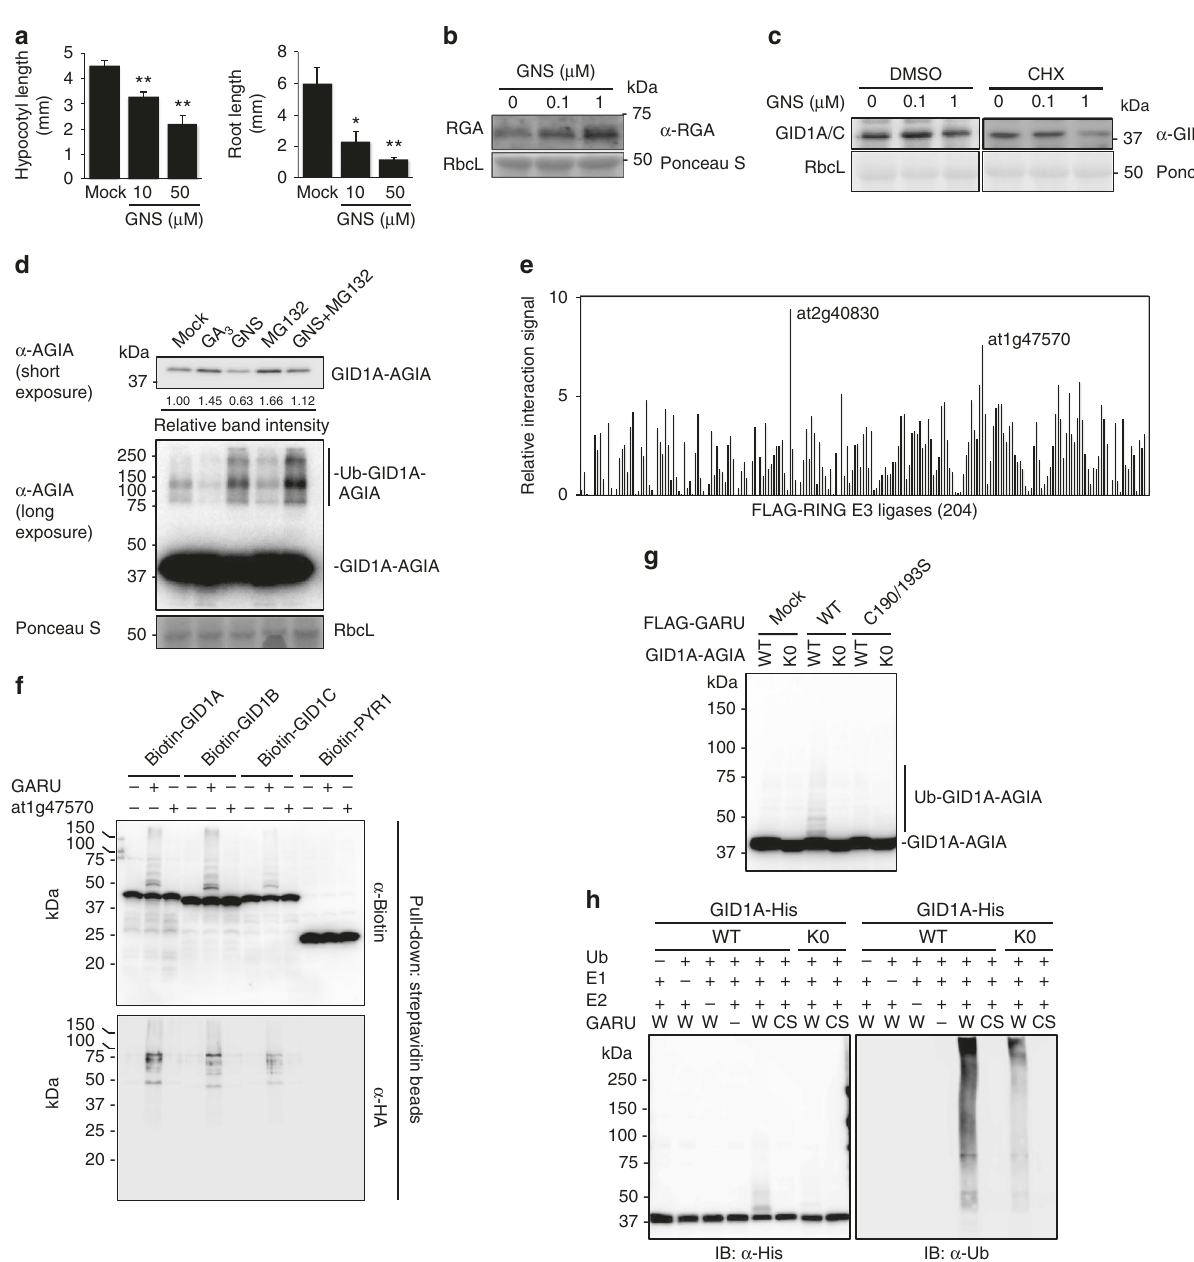
Fig. 1 Identi fi cation of GID1-interacting RING-type E3 ubiquitin ligase GARU. a Hypocotyl elongation assay of etiolated seedlings (left) and primary root elongation assay (right) in response to GNS. Error bars indicate ± s.d. of three replicates, n = 24 (hypocotyl), and n = 20 (root). Statistically signi fi cant changes compared with Mock are indicated ( *P < 0.05, **P < 0.01, as determined using two-tailed Student ’ s t -test). b Immunoblot analysis of RGA protein in Col-0 seedlings that were treated with GNS for 6 h. c Immunoblot analysis of endogenous GID1A/C proteins in Col-0 seedlings that were treated with GNS and 300 μ M CHX for 6 h. d Immunoblot analysis of GID1A-AGIA in protoplasts that were treated with 10 µ M GA 3 , 5 µ M GNS, or 20 µ M MG132 for 6 h. Relative protein level was calculated as the signal intensity ratio of the Mock. e PPI analysis of biotin-GID1A and 204 FLAG-E3s. f In vitro ubiquitination assay using the top two interacting clones. Biotin-GID1A, GID1B, and GID1C were incubated with recombinant HA-tagged ubiquitin and E2 in the presence (+) or absence ( − ) of FLAG-tagged GARU or at1g47579 protein. After incubation, reaction mixture was boiled in 2% SDS, and biotin-GID1 proteins were collected by af fi nity puri fi cation using streptavidin magnetic beads. Biotin-GID1 proteins and HA-ubiquitin were detected by immunoblot analysis using anti-biotin antibody or anti-HA antibody. PYL1 was negative control. g In vitro ubiquitination assay using GID1A K0 mutant. C-terminal AGIA-tagged GID1A (WT) or GID1A K0 mutant (K0) was incubated with FLAG-GARU (WT) or FLAG-GARU C190/193S mutant (C190/193S). Ubiquitinated GID1A (Ub-GID1A- AGIA) proteins were detected by immunoblot analysis using anti-AGIA antibody. h In vitro ubiquitination assay using puri fi ed GID1A and GARU. Af fi nity puri fi ed GID1A-His or GID1A K0 -His was incubated in the presence (+) or absence ( − ) of ubiquitin (Ub), recombinant E1, E2, wild-type FLAG-GARU (W), and FALG-GARU C190/193S mutant (CS). GID1A-His and ubiquitinated proteins were detected by immunoblotting using anti-His antibody or